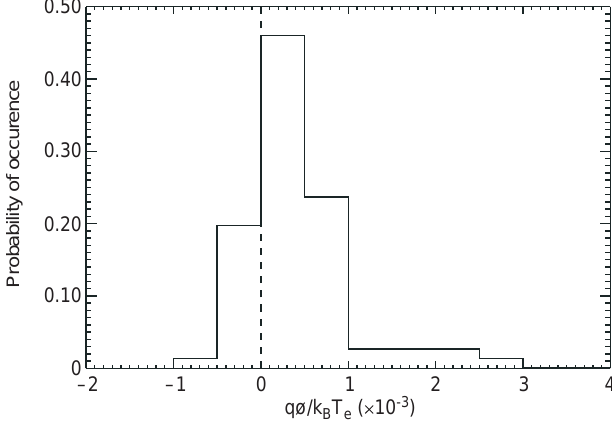
Fig. 7. Histogram of the normalised potential jump for 75 weak double layers selected as described in